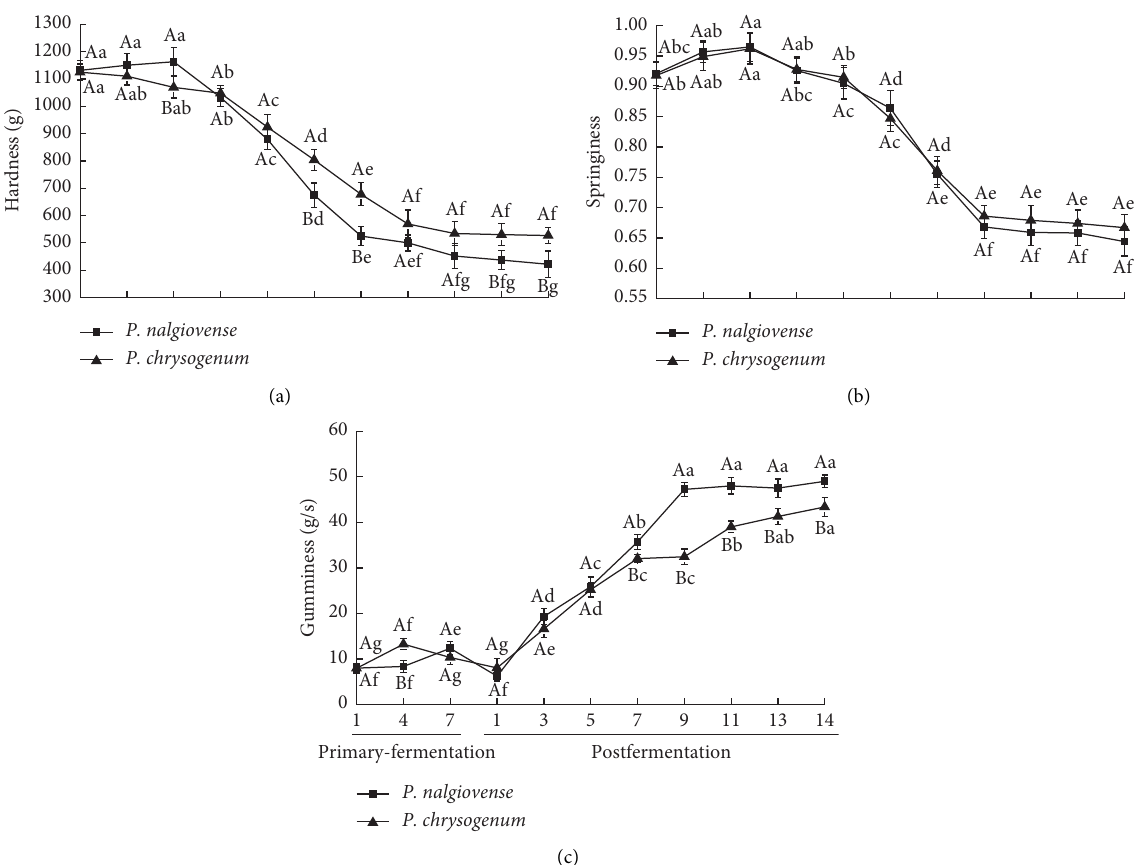
Figure 1: Effect of fermentation with two molds on hardness (a), springiness (b), and gumminess (c) of chicken meat. The different lowercase and uppercase letters indicate statistical differences for fermentation time and treatments at p < 0.05, respectively. Samples from ten pieces of chicken breast meat for each treatment were